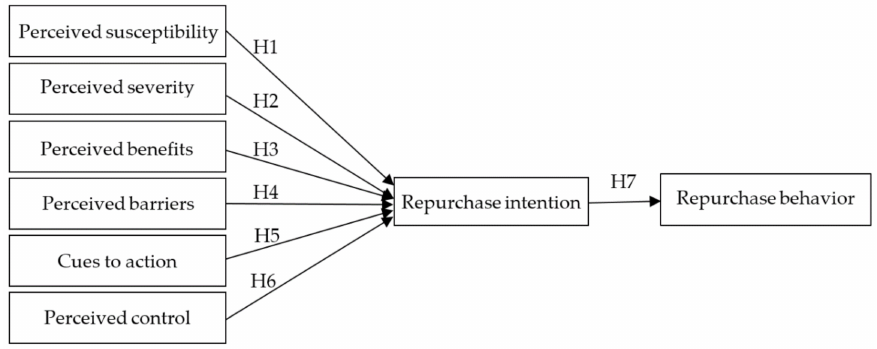
Figure 2. Research